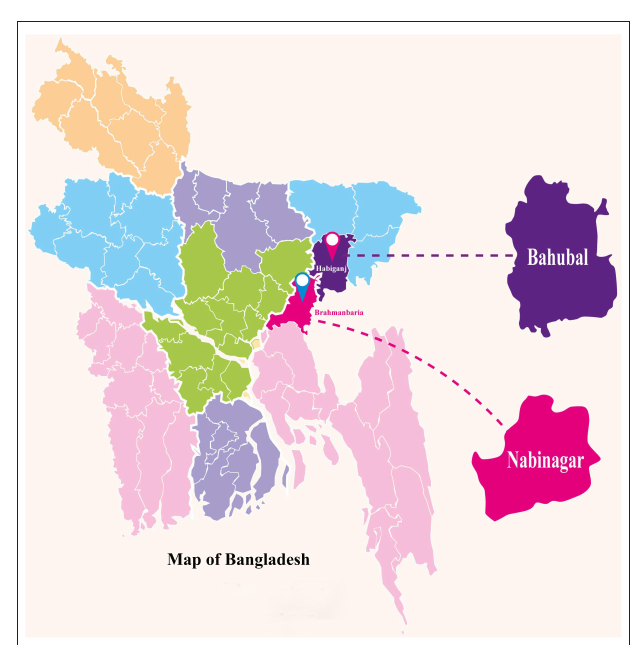
FIGURE 1 | The study areas (illustration: Authors’